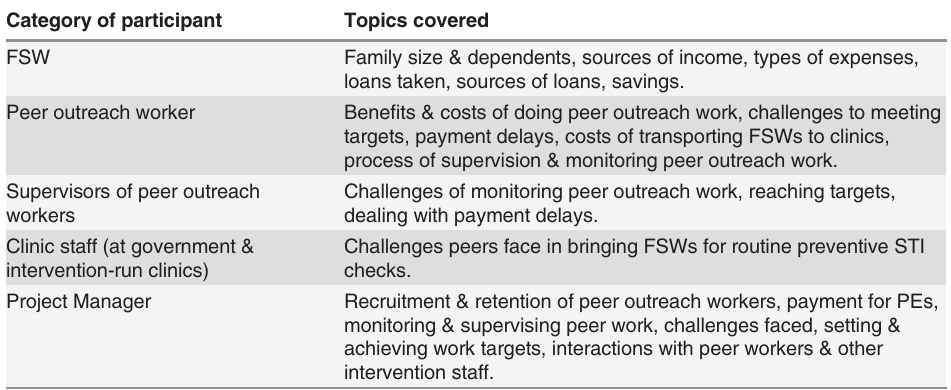
Table 2. Participants with whom informal conversations were held to understand costs and bene fi ts to FSW of working as peer outreach workers. Category of